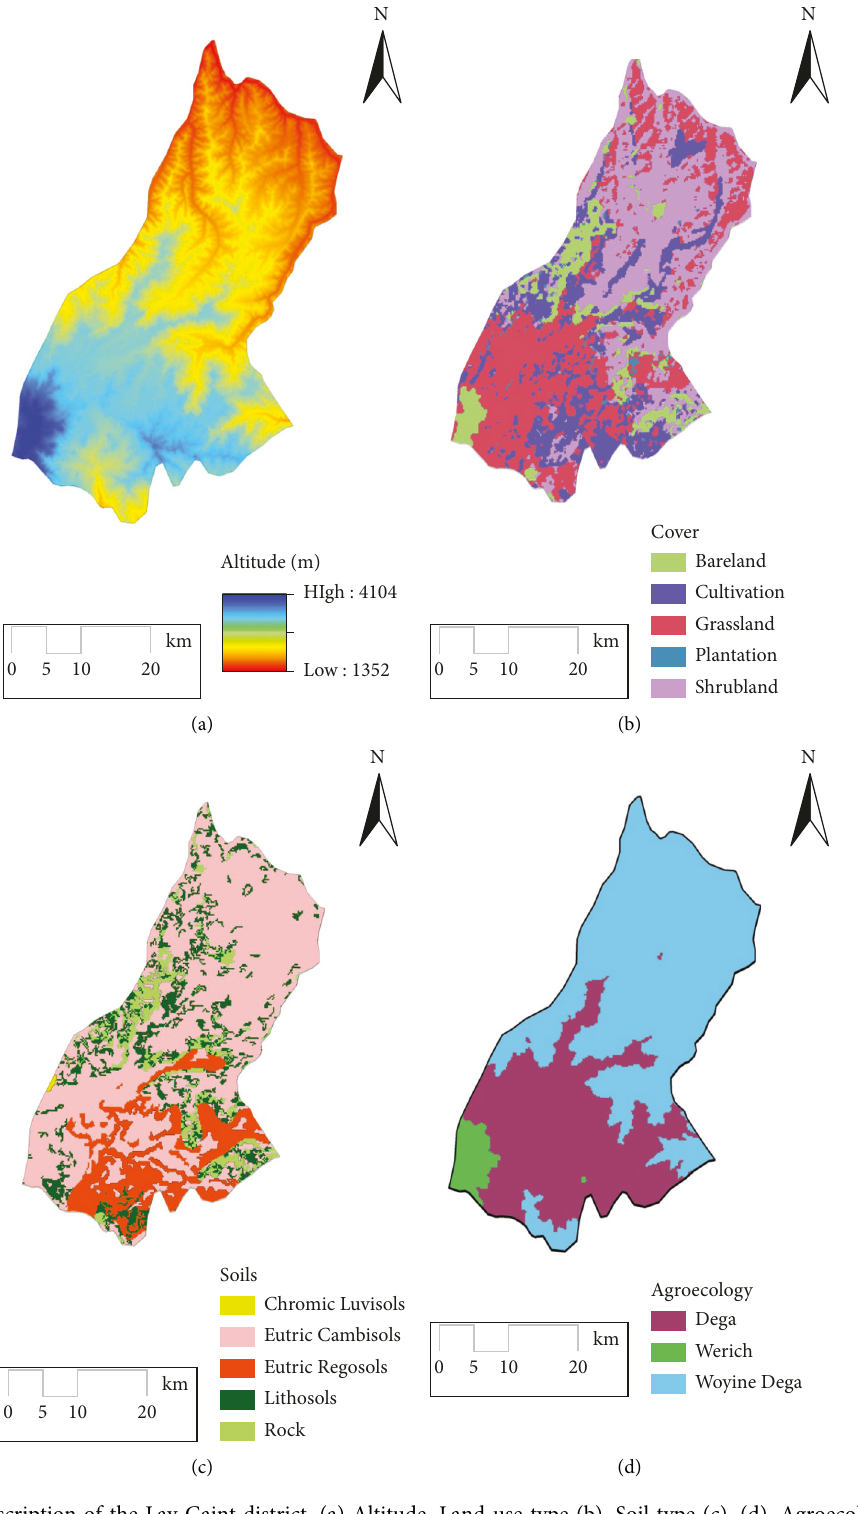
Figure 3: Description of the Lay Gaint district. (a) Altitude. Land-use type (b). Soil type (c). (d). Agroecology